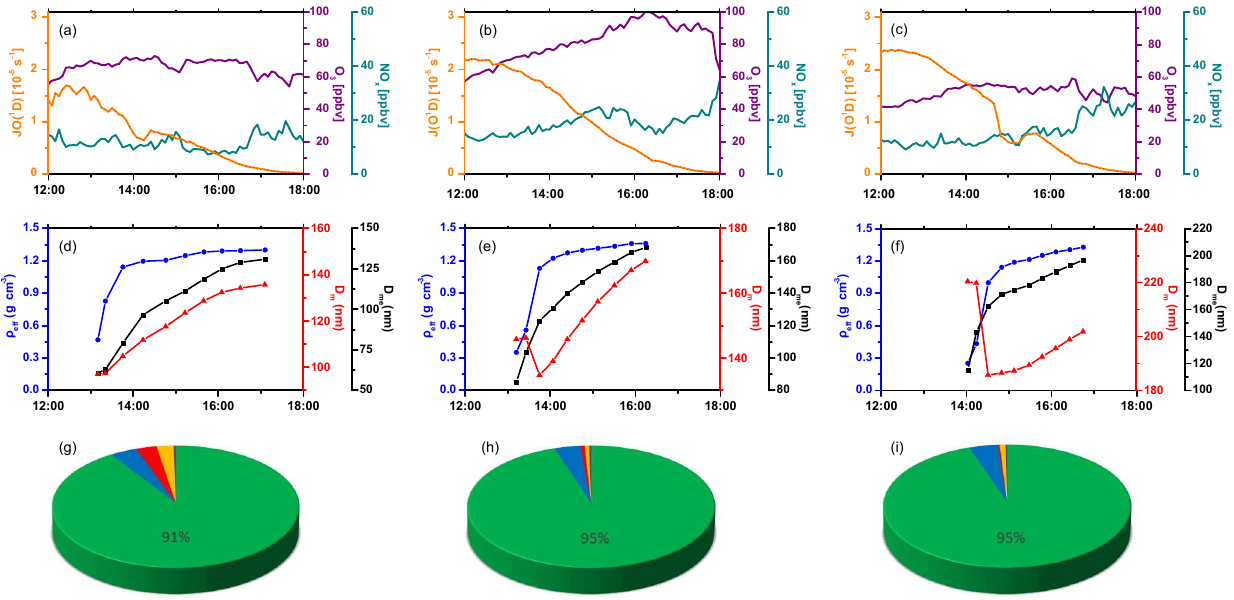
Figure 8. Ambient condition (a, b, c) , changes of diameter and density of BC particle (d, e, f) , and the chemical composition of coating materials (g, h, i) during three typical ageing experiments. Panels (a, d) correspond to experiment 4, (b, e) correspond to experiment 5, and (c, e) correspond to experiment 9. D m is the peak mobility diameter of BC particles, ρ eff is the best-fit effective density of BC particles with the mobility diameter D m , D me is the mass equivalent diameter of BC particles, and J (O 1 D) represents the measured photolysis rate constant for O( 1 D). The colours of green, blue, red, yellow and purple in the pie charts represent organics, nitrate, sulfate, ammonium and chlorine, respectively. The numbers in panels (g, h, i) are the mass fraction of